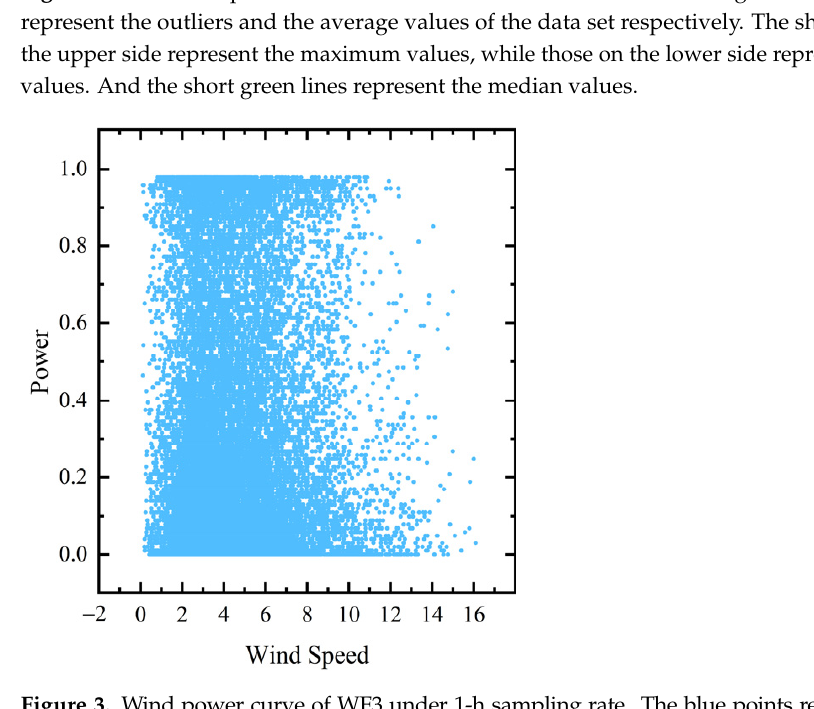
Figure 2. The wind power data characteristics of 7 wind farms. The green triangles and circles rep ‐ resent the outliers and the average values of the data set respectively. The short purple lines on the upper side represent the maximum values, while those on the lower side represent the minimum values. And the short green lines represent the median values.